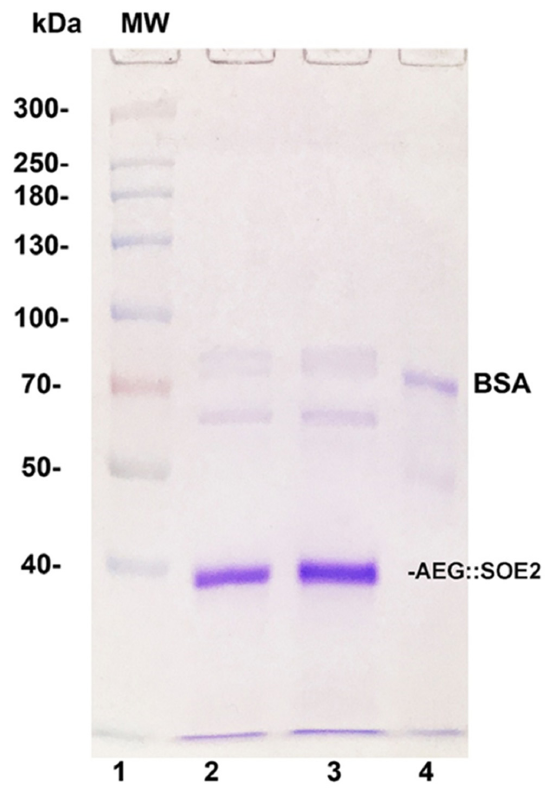
Figure 2. Sodium dodecyl sulfate-polyacrylamide gel electrophoresis (SDS-PAGE) in 8% acrylamide of AEG::SOE2 from two different experiments (lanes 2 and 3) after purification by Ni 2+ NTA affinity chromatography. Lane 1 is of molecular weight (MW) standards, and numbers refer to daltons ( × 1000). Lane 4 is of 1 μ g bovine serum albumin (BSA) electrophoresed for comparative purposes.